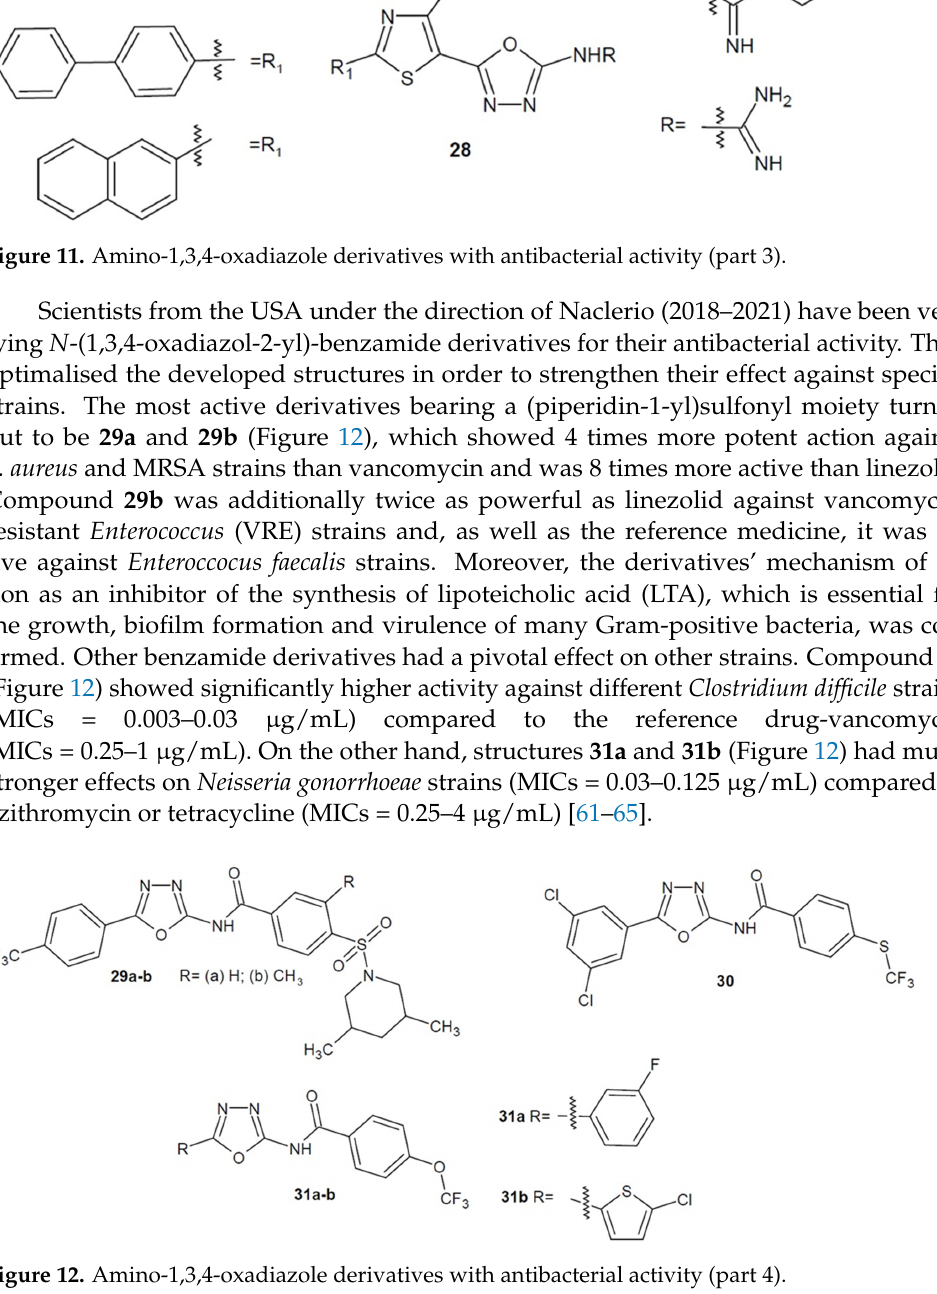
Figure 12. Amino-1,3,4-oxadiazole derivatives with antibacterial activity (part 4).